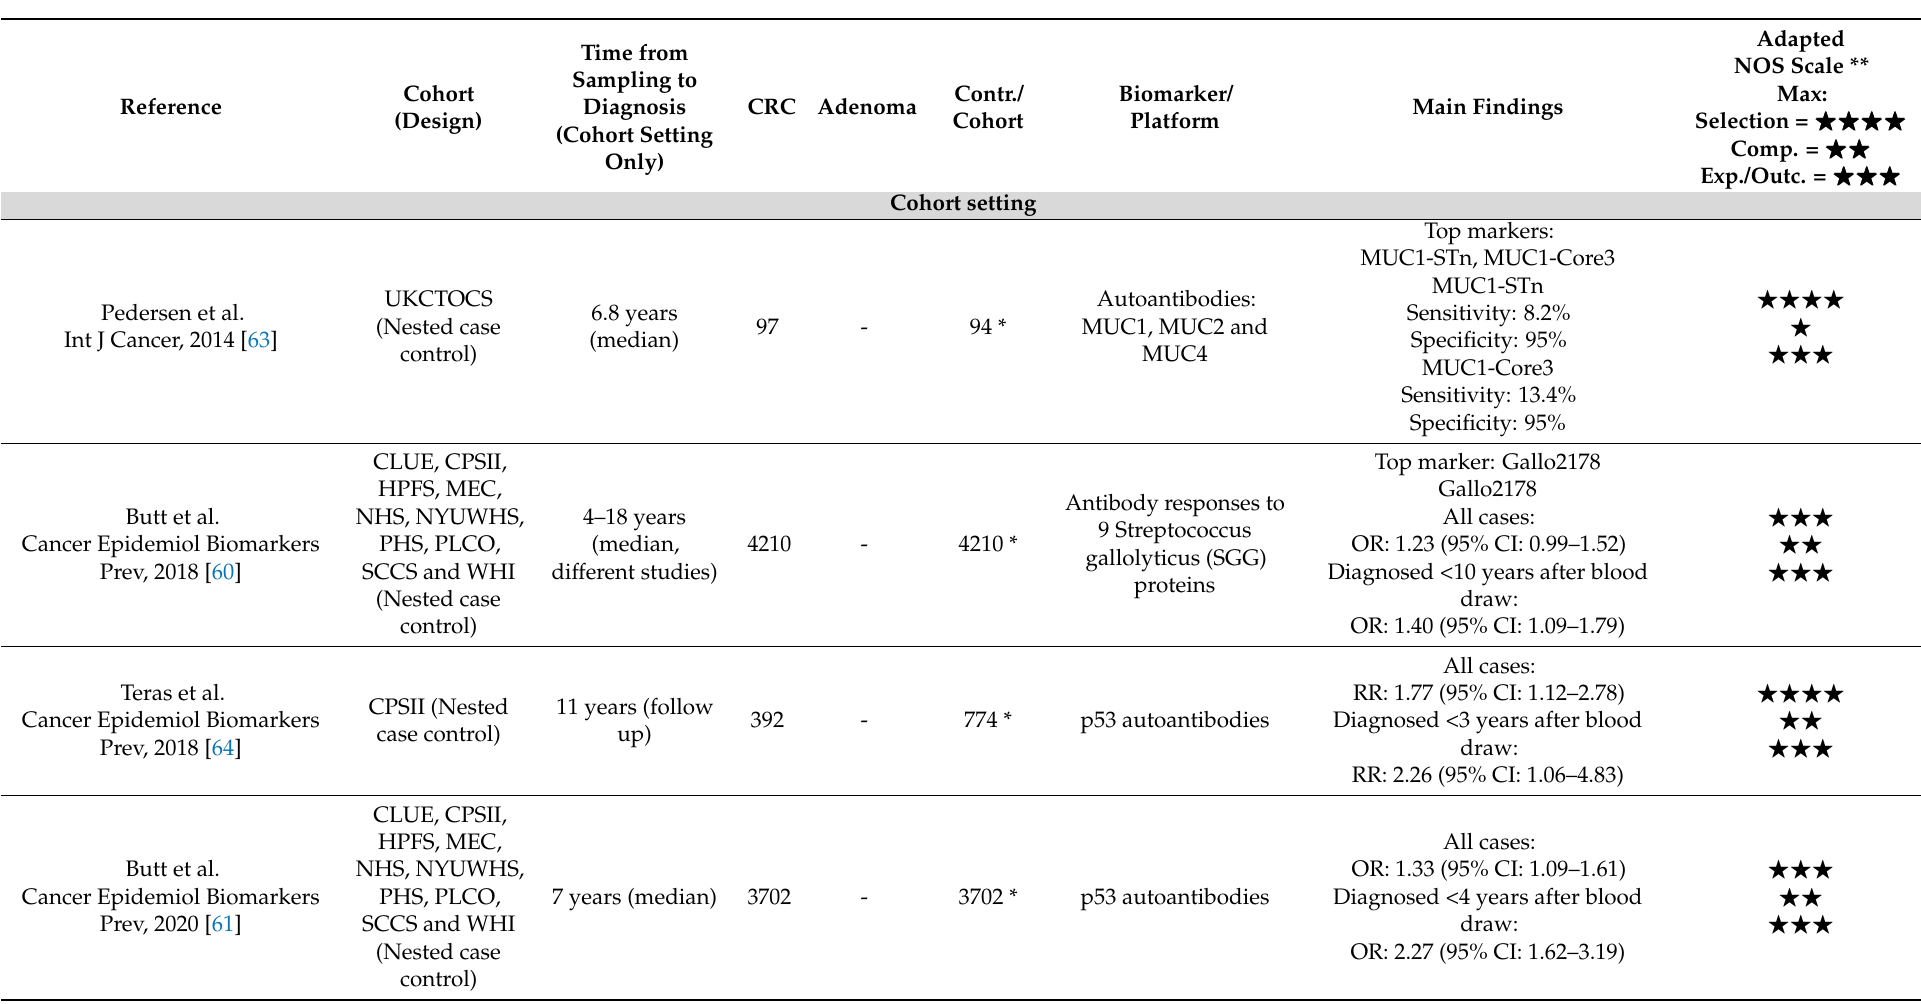
Table 3. Studies of antibodies analyzed in pre-diagnostic blood samples (collected in prospective cohort or general screening settings) for the purpose of risk prediction or early diagnosis of colorectal